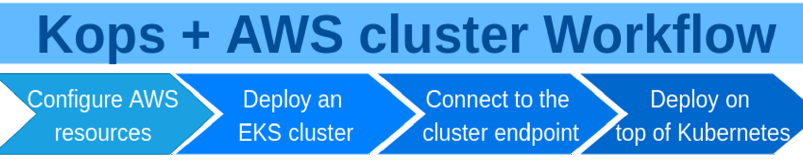
Figure 3. Stages of working with Kubernetes cluster deployed on AWS with kops.